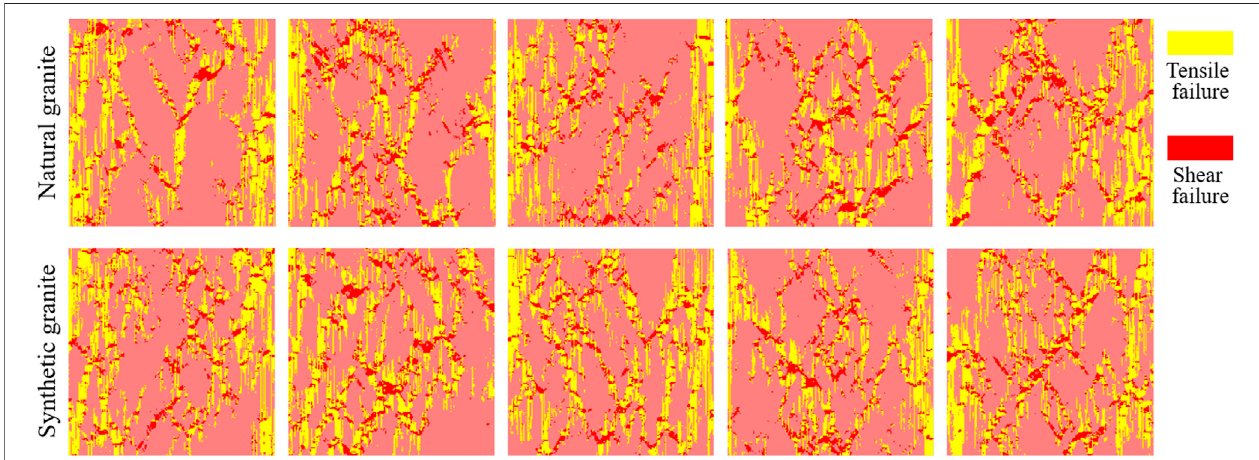
FIGURE 7 | The failure patterns of natural granite and equal-size synthetic granite.